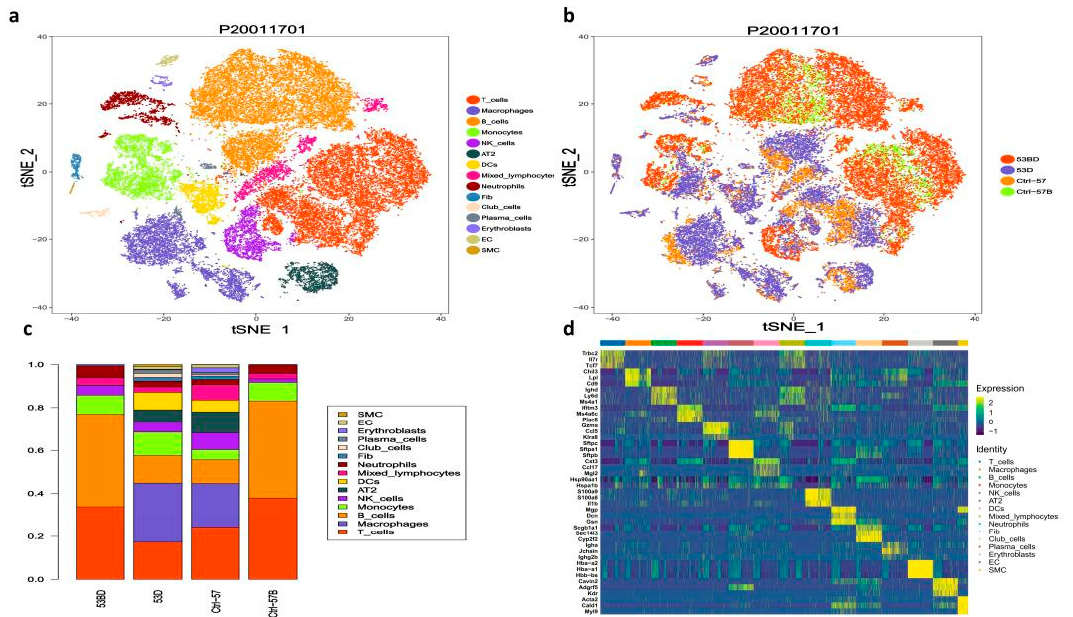
Figure 1. Overview of the lung tissue of radiation pneumonitis (RP) mice and control mice. ( a ) Schematic diagram of experiment design. ( b ) H&E staining of representative sections is shown. ( c ) A summary of histology scores assigned to each group.